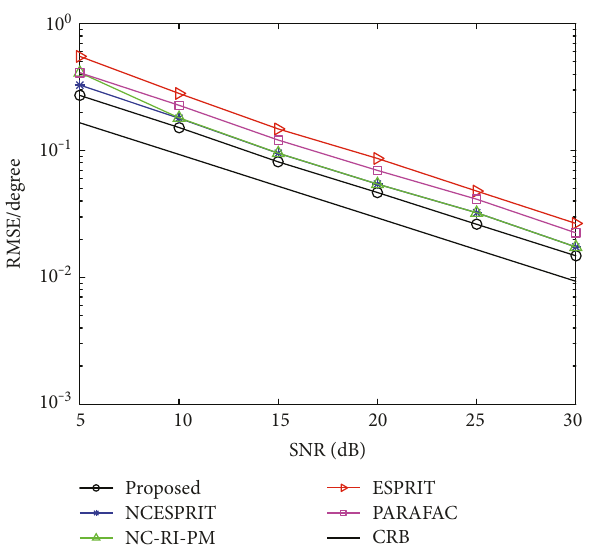
Figure 4: RMSE performance of di ff erent methods versus